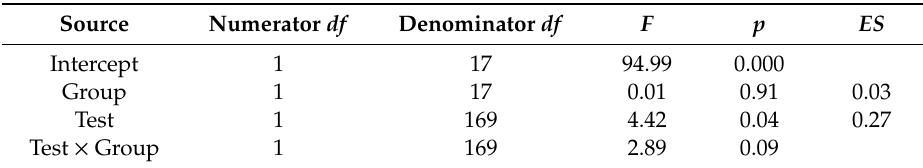
Source Numerator df